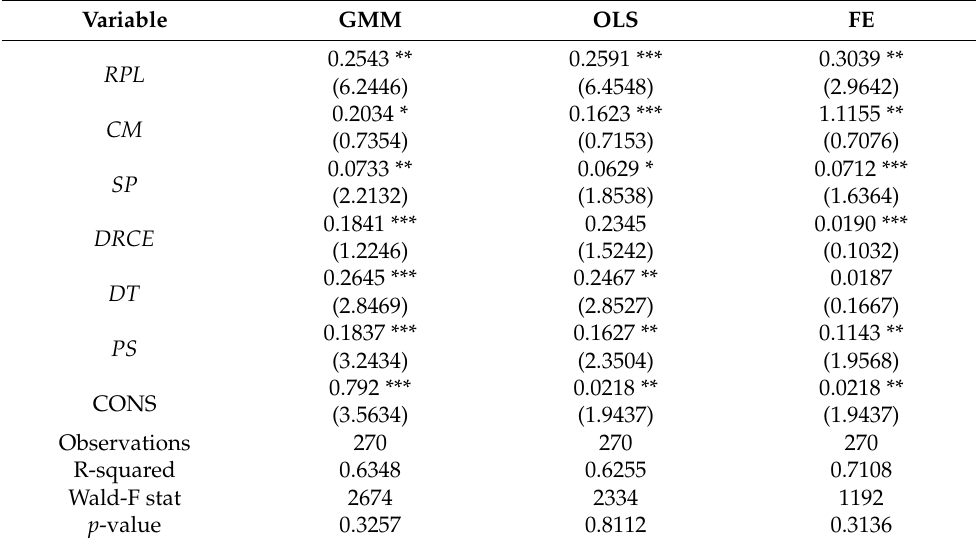
Table 6. Regression analysis results under the instrumental variable method.